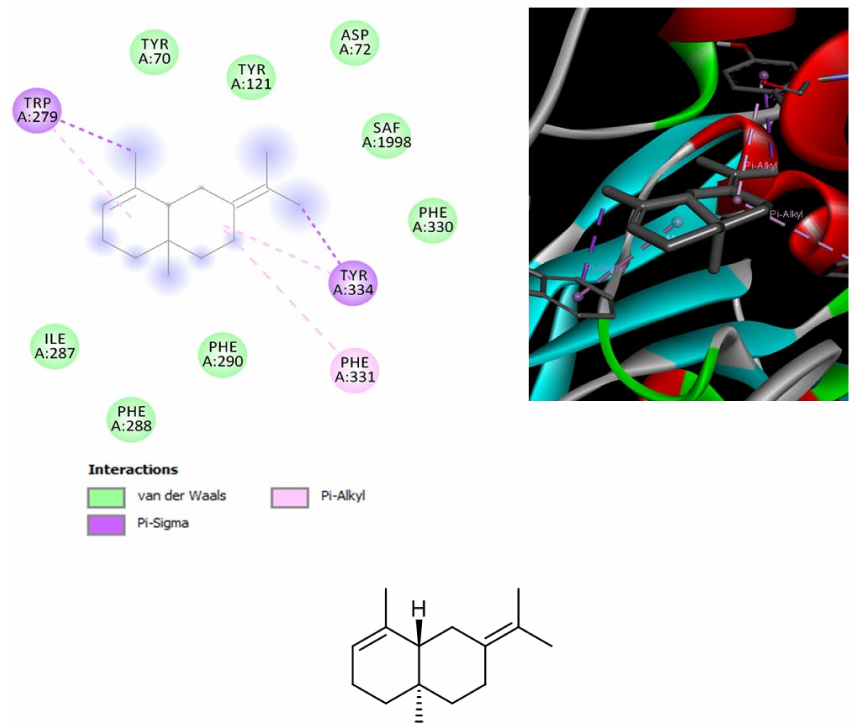
Figure 5. Structure and in silico interactions between selina-3,7(11)-diene and acetylcholinesterase (AChE; PDB: 1GQR). Free energy of binding ( ∆ G) and affinity (Ki) are − 7.2 kcal/mol and 5.4 µ M,